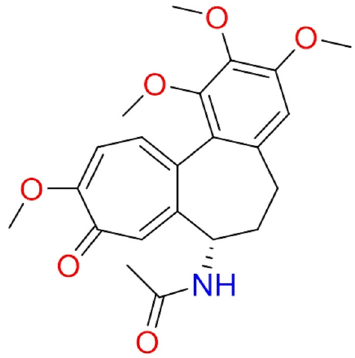
Figure 9. 2D structure of colchicine.